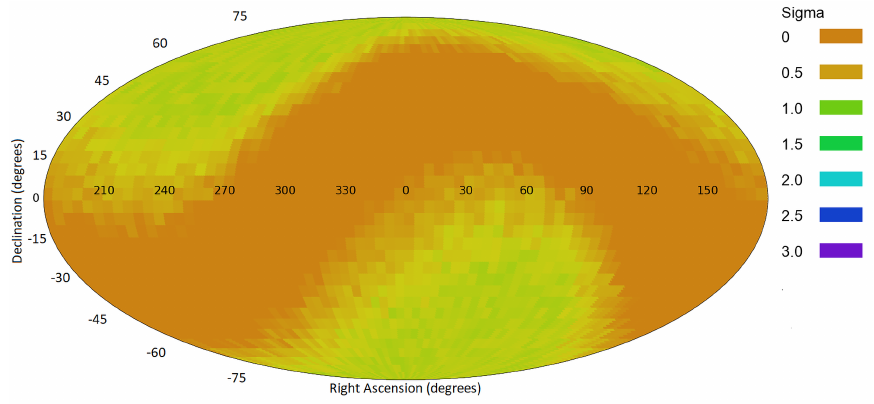
Figure 12. The χ 2 statistical significance of a possible dipole axis from all possible integer ( α , δ ) combinations when the spin directions of the galaxies are assigned